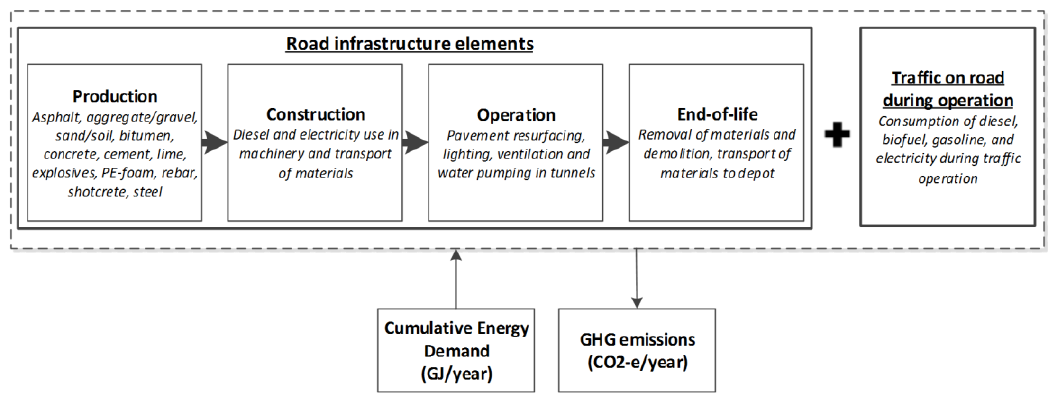
Figure 2. LICCER model structure, adapted from (Brattebø, et al.,